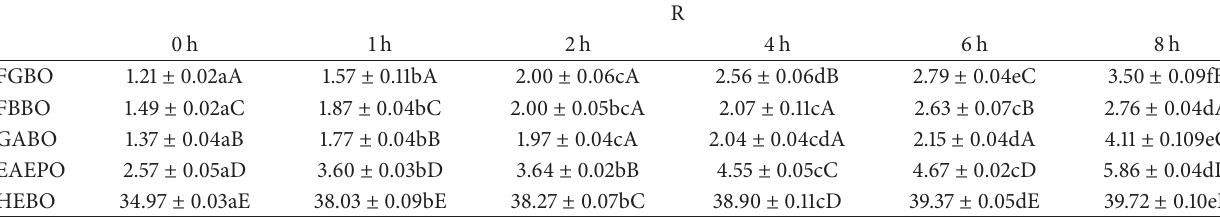
Table 2: Variation of red color of blended oils.